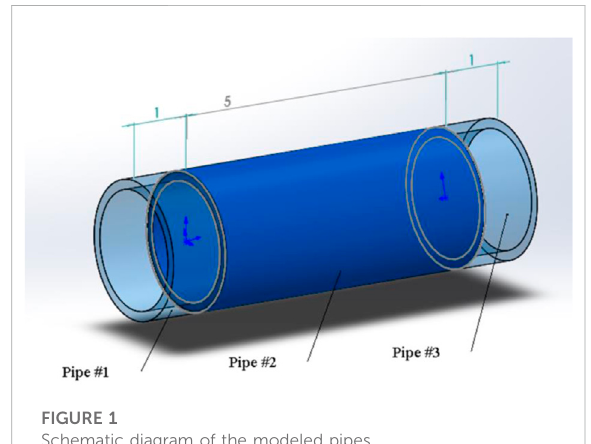
FIGURE 1 Schematic diagram of the modeled